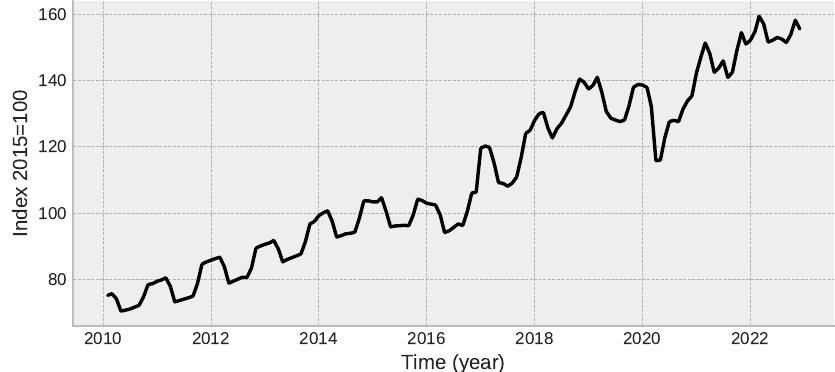
Figure 1. Original data of the normalized consumer energy price in